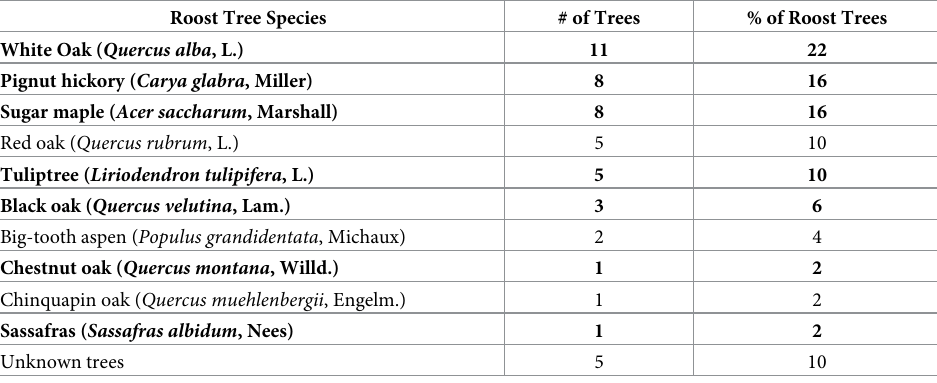
Chinquapin oak ( Quercus muehlenbergii , Engelm.) Sassafras ( Sassafras albidum , Nees) Unknown trees 5 10 Roost Tree Species in bold represent tree species used by Cerulean Warblers for nesting. If a specific roost tree could not be identified due to multiple tree canopies coming into contact, it was placed into the unknown category.